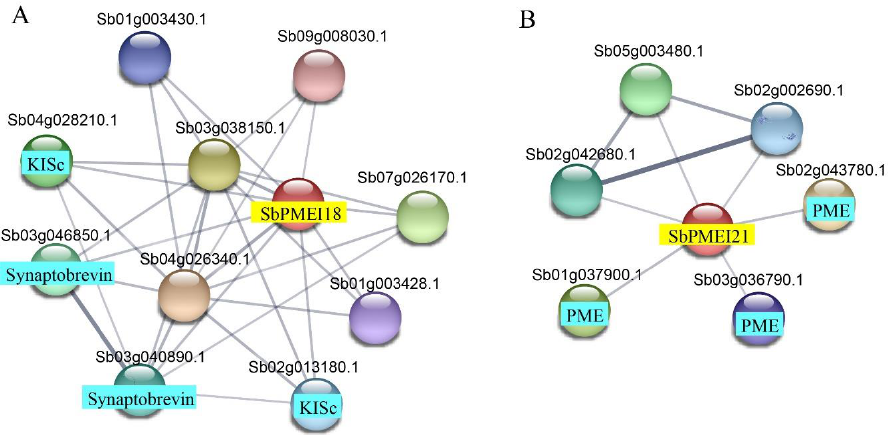
Figure 5. Protein–protein interaction networks of SbPMEI18 and SbPMEI21. ( A ) The interaction network of SbPMEI18. ( B ) The interaction network of SbPMEI21. The networks were generated from the STRING database. The red balls represented the queried protein while the other balls were the identifier. The annotation of the predicted protein was derived from UniProtKB (https://www.uniprot.org/). Line thickness indicates the strength of data support.